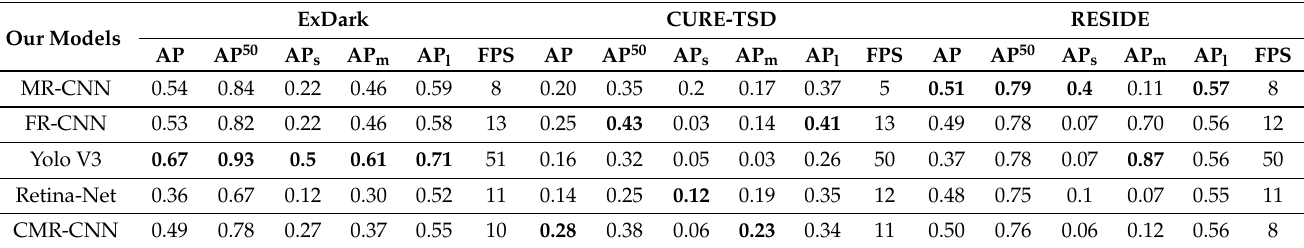
Table 5. Object detection performance comparison on three challenging datasets. MR-CNN, FR-CNN, and CMR-CNN represent Mask R-CNN, Faster R-CNN, and Cascade Mask R-CNN, respectively. AP s denotes average precision for small area at IOU = 0.50:0.95. AP m represents average precision for medium area at IOU = 0.50:0.95 and AP l depicts average precision for large area at IOU = 0.50:0.95. FPS highlights the speed of object detection networks at inference time in terms of frames per